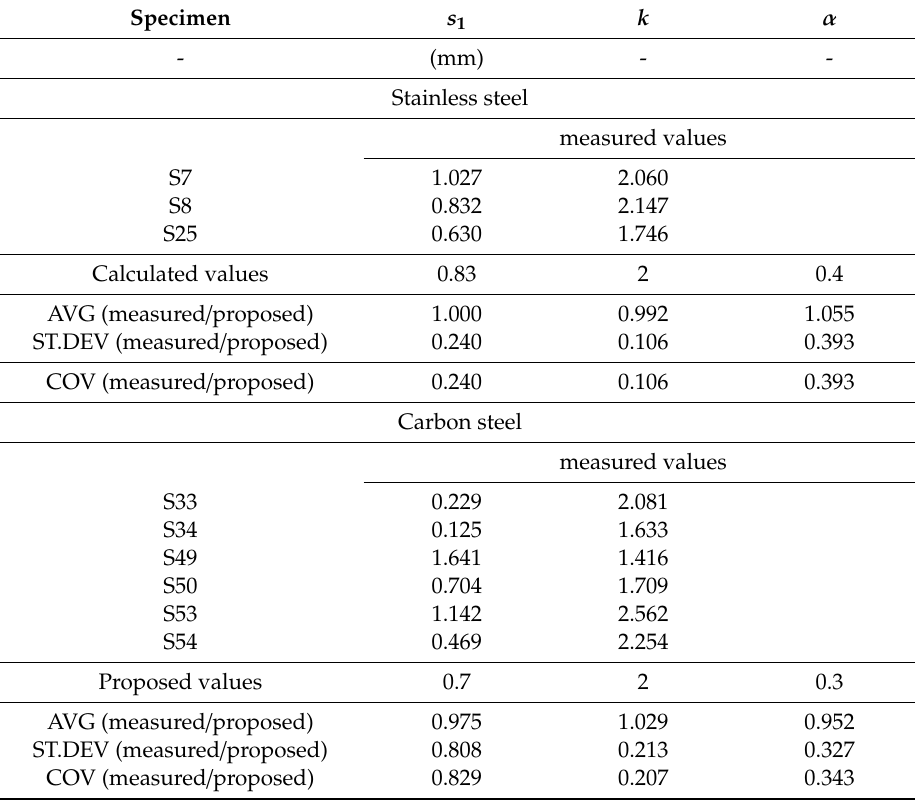
Table 2. Parameters of the bond stress–slip relationships obtained from statistical